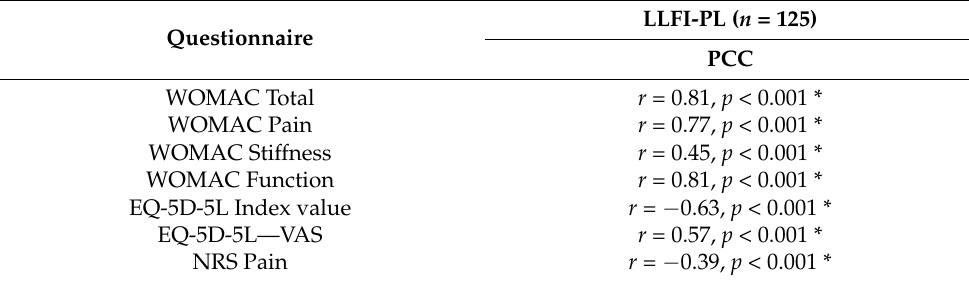
Table 4. PCC between the LLFI-PL and the WOMAC, the EQ-5D-5L, and the Pain